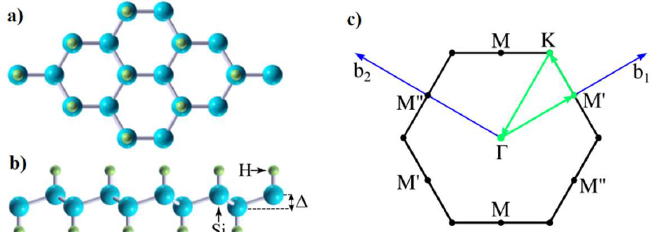
Figure 1. ( a ) Top view and ( b ) cross-view of the silicane structure; ( c ) reciprocal lattice of silicane in which b 1 and b 2 represent reciprocal lattice vectors and Γ, K, and M are the high symmetry points of the first Brillouin zone (FBZ). Table 1. Silicane characteristics.